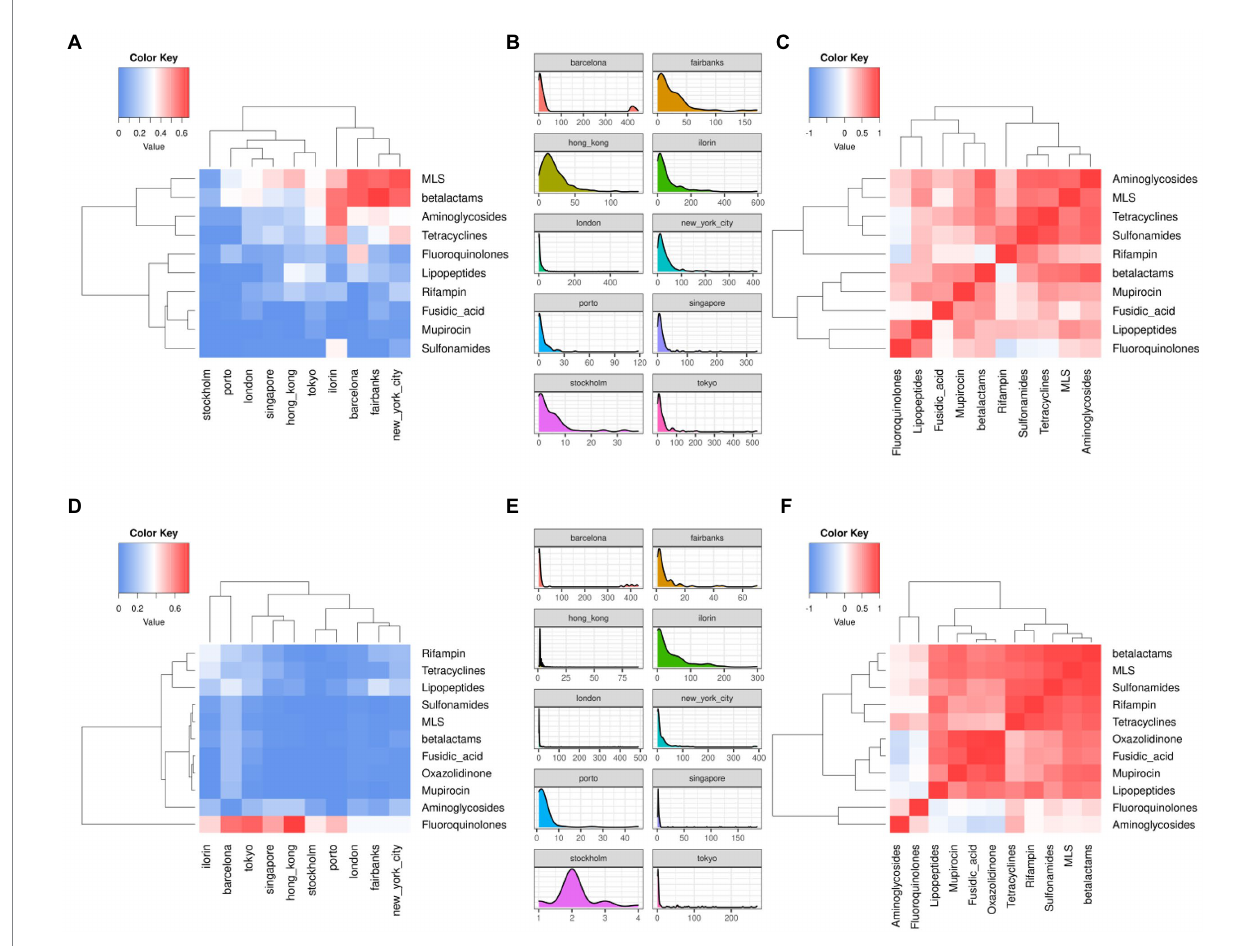
FIGURE 6 Correlation heatmaps (fraction of counts per antibiotic resistance class over the city total) and density plots of antibiotic resistance genes (ARGs, Panels A–C ) and ARG variants (ARGVs, Panels D–F ), among the top-10 cities and resistance types using the MetaSUB annotated samples ( n =